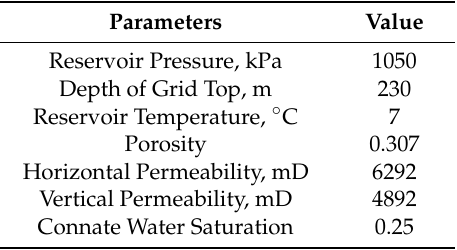
Table 1. Basic reservoir parameters in the Long